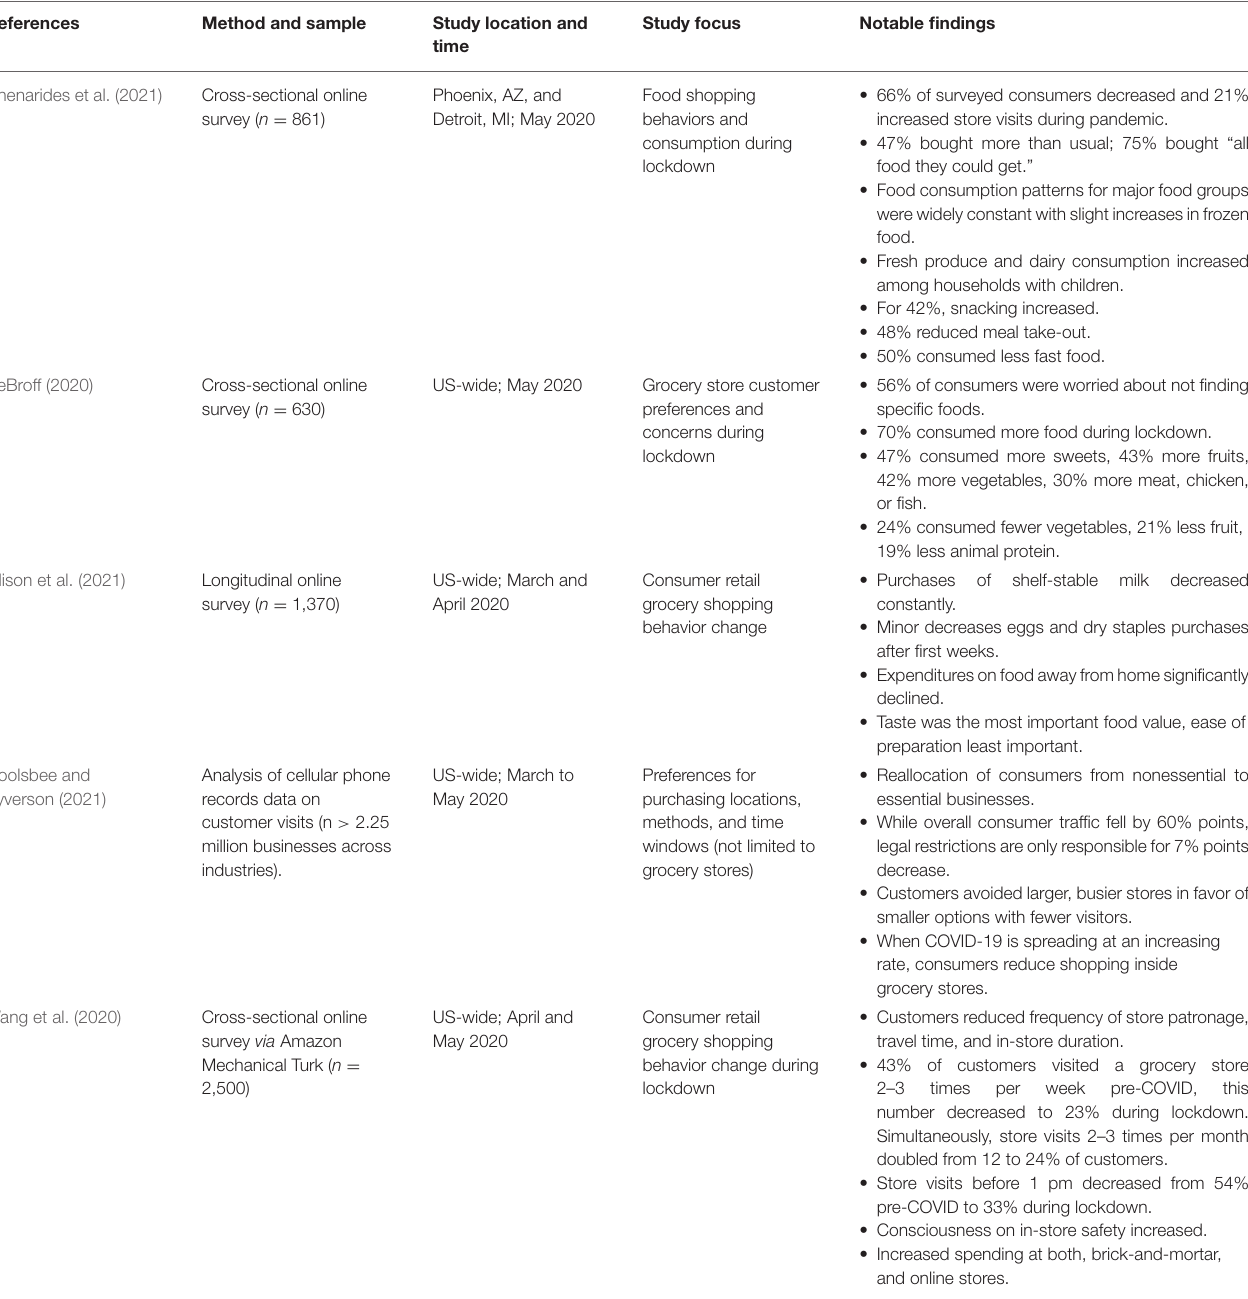
TABLE 1 | Overview of studies on US food consumption patterns during March and April